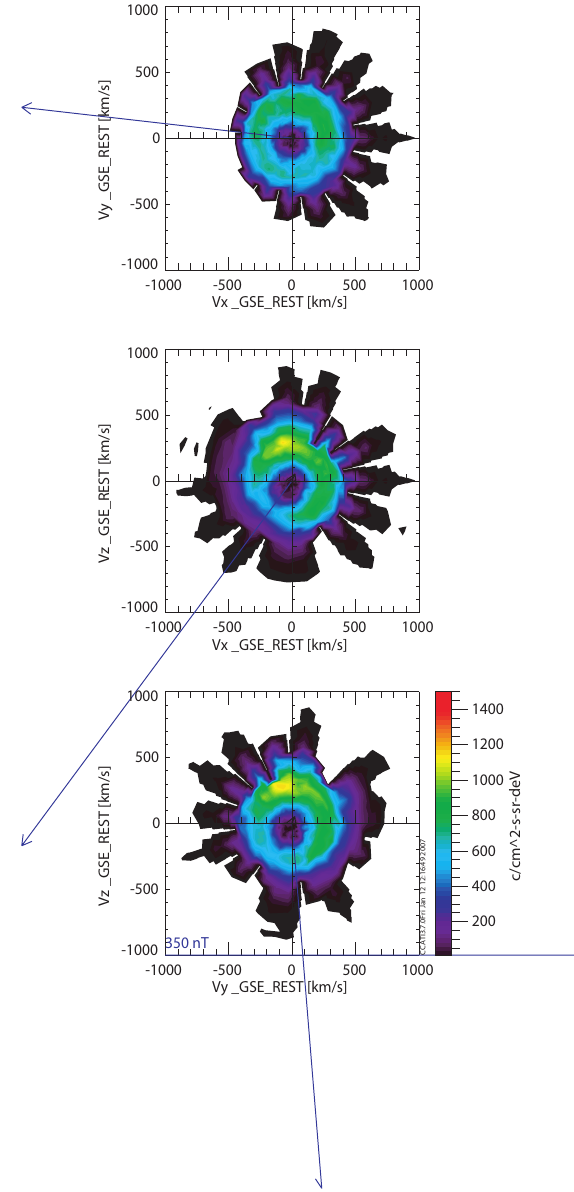
Fig. 8. Contours of the differential energy flux (units shown on the color bar) observed by CIS on the C4 spacecraft integrated over the time interval 07:20:13 to 07:22:26. The axes are GSE coordinates and the blue arrow indicates the direction of the magnetic field.